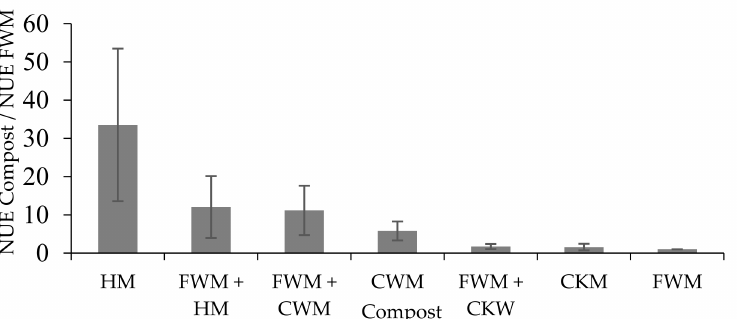
Figure 4. NUE improvement of FWM combined with animal manure. HM = horse manure; CKM = chicken manure; CWM = cow manure; FWM = foot waste manure; FWM + HM = food waste manure compost combined with horse manure; FWM + CKM = food waste manure compost combined with chicken manure; and FWM + CWM = food waste manure compost combined with cow